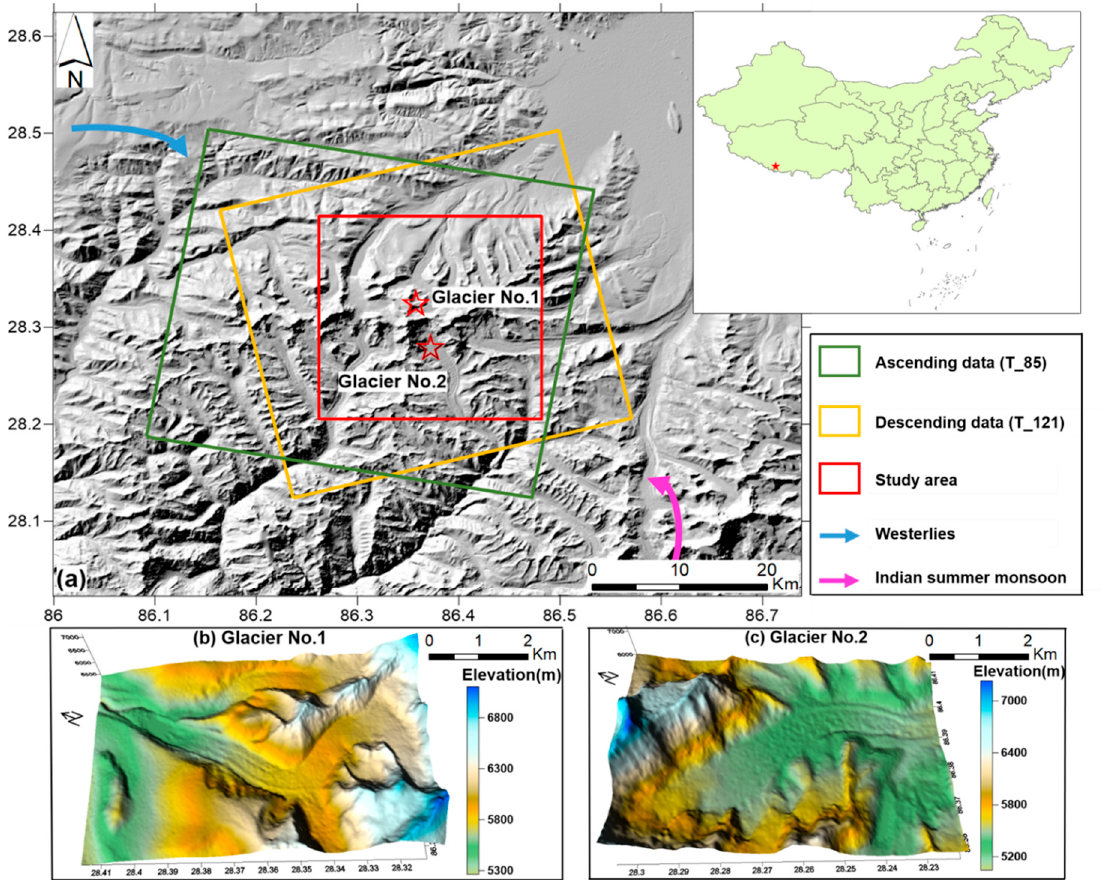
Figure 1. Study area and SAR dataset coverages: ( a ) Spatial coverage of ascending and descending Sentinel-1 datasets represented on SRTM DEM; ( b ) The terrain of glacier No.1, ( c ) The terrain of glacier No.2.